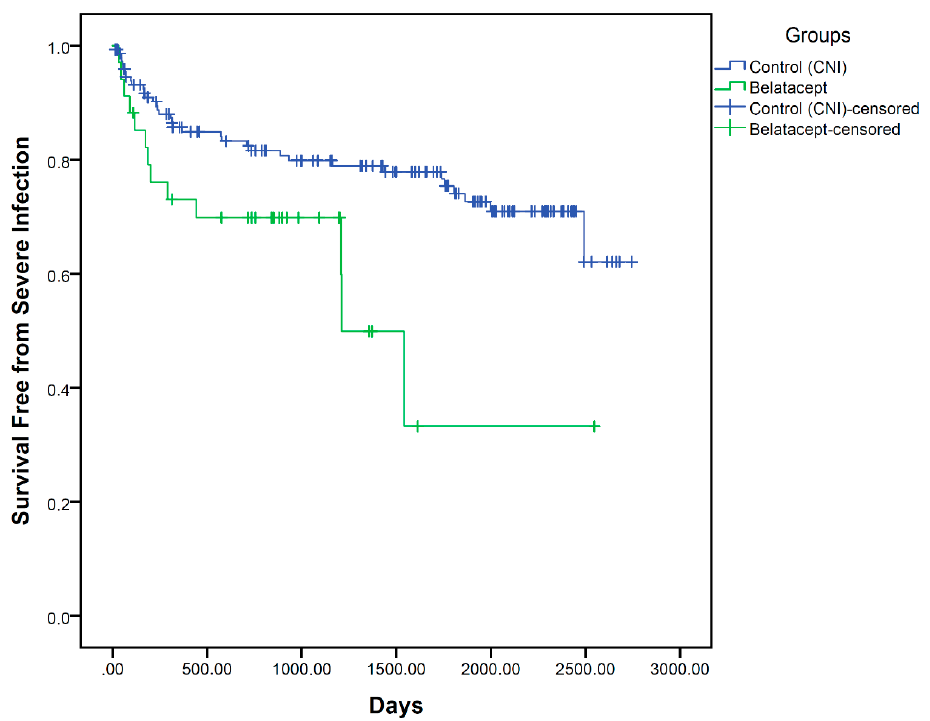
Figure 1. KM-Plot for severe infection (Log-Rank p = 0.013), defined as infection leading to the admission of the patient to hospital. Table 5. Efficacy and safety endpoints at last follow-up. p -values < 0.05 are marked with an asterisk *. CMV: cytomegalo virus, BKV: polyoma virus.